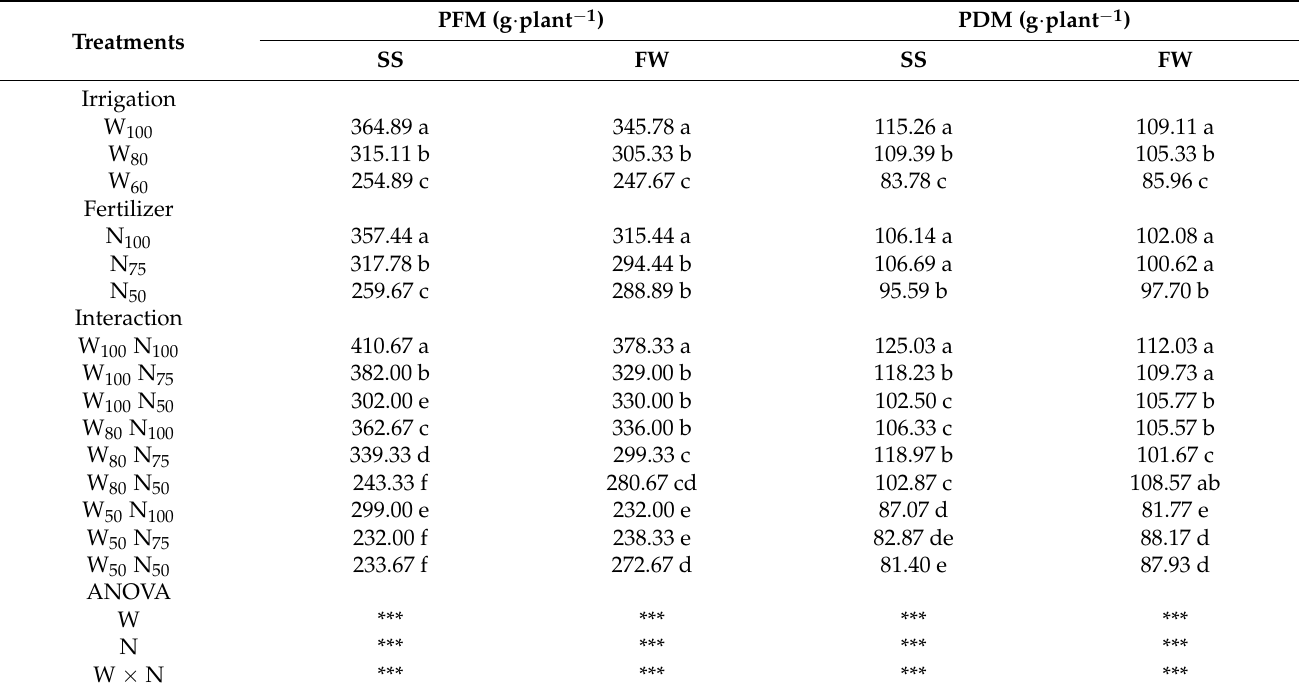
Table 3. Effect of irrigation and fertilizer levels on plant fresh and dry biomass during spring–summer (SS) and fall–winter (FW)